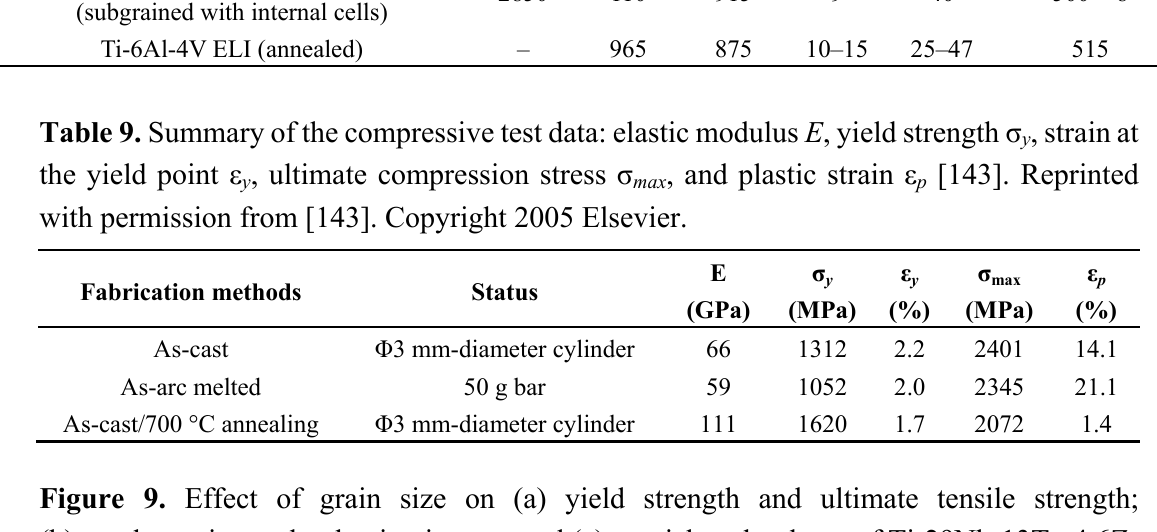
, strain at y , and plastic strain ε [143]. Reprinted max p